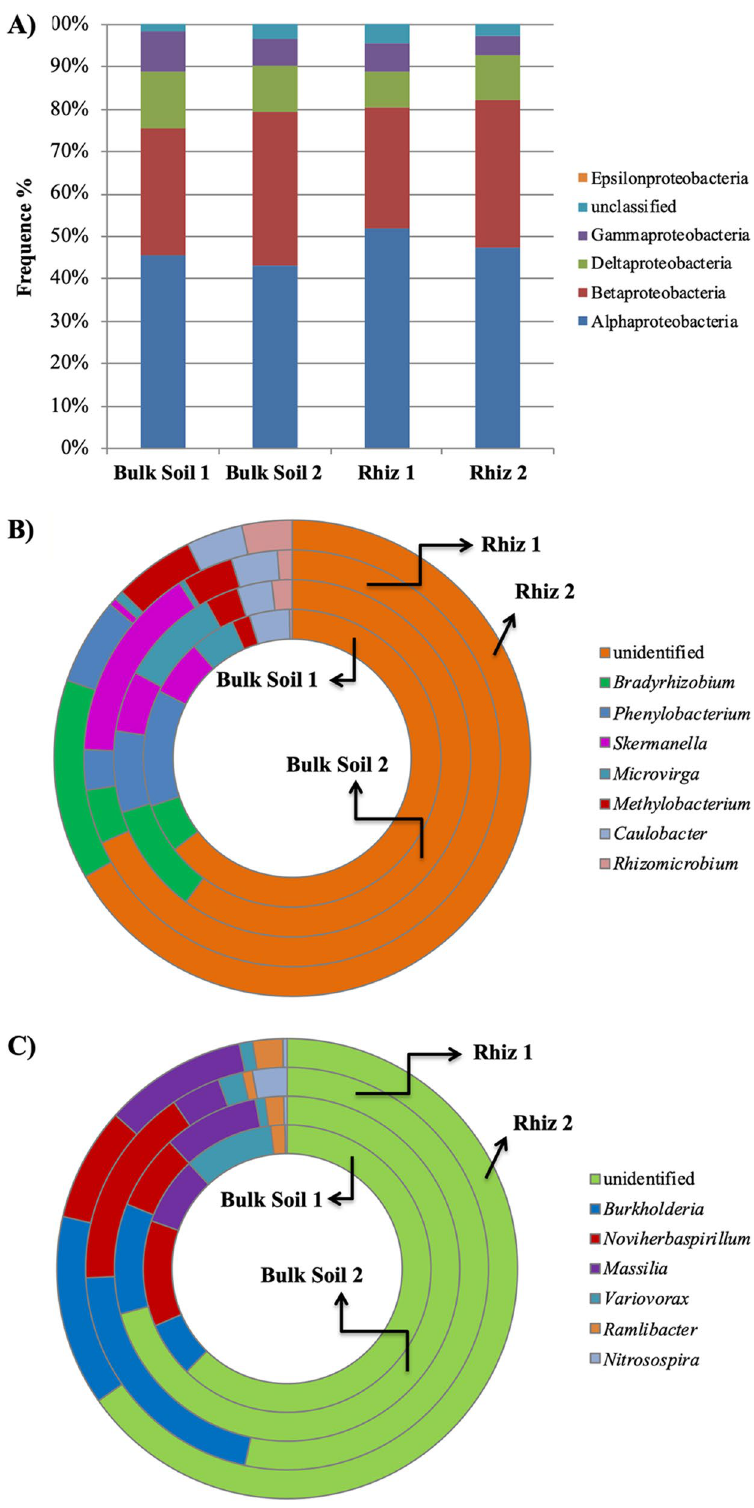
Figure 7. Distribution of ( A ) the different classes of Proteobacteria; ( B ) the genera belonging to the class α-Proteobacteria and ( C ) the genera belonging to the class β-Proteobacteria in bulk soil and rhizosphere of V. vinifera cv. Pinot Noir at the two sampling dates (flowering and early fruiting stages). From the centre to the edge Bulk Soil 1, Bulk Soil 2, Rhiz 1, Rhiz